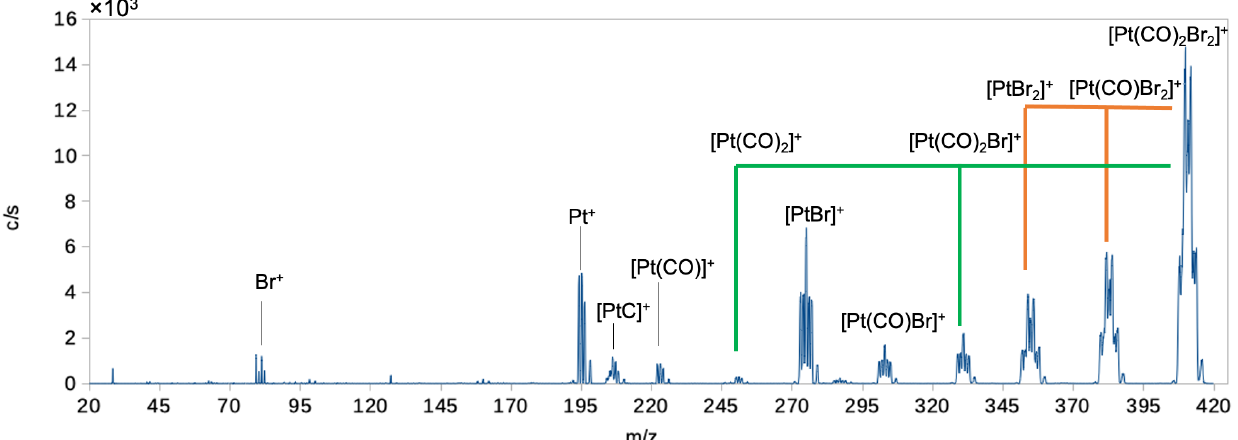
Figure 6. Positive ion mass spectrum of Pt(CO) 2 Br 2 recorded at 70 eV incident electron energy. Green lines show the se- quential loss of the two Br ligands, while orange lines show the sequential loss of the two CO ligands.